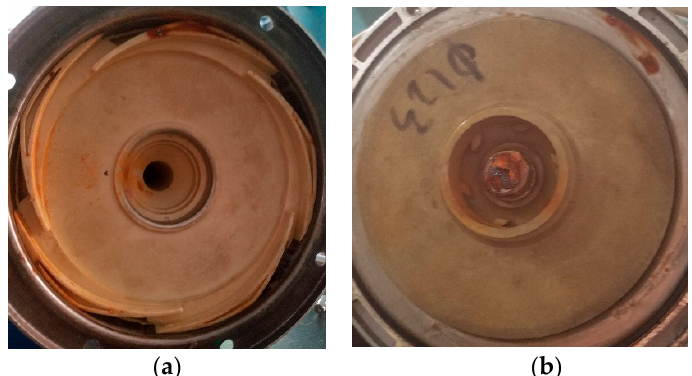
Figure 1. Pictures of impeller and guide vane of the model pump. ( a ) Guide vane of the jet centrifugal pump (JCP); ( b ) Impeller of the JCP.